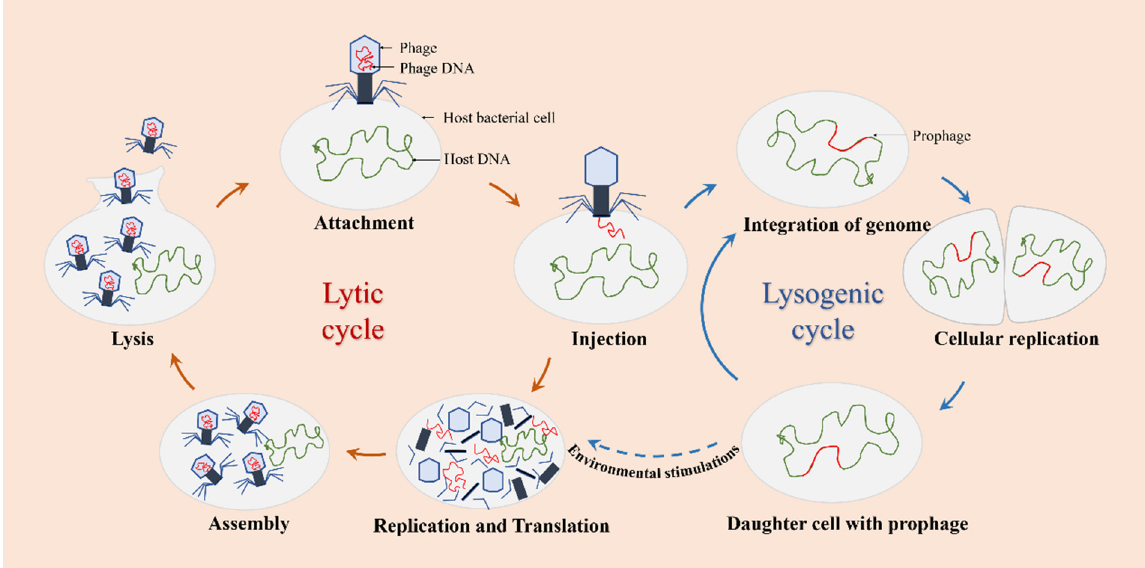
Figure 2. The life cycle of phages. Lytic phages only go through the lytic cycle, and lysogenic phages can go through the lytic or the lysogenic cycle.